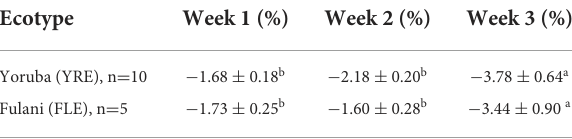
TABLE 4 Relative weight loss (%) of the broody hens over the three-week brooding period.